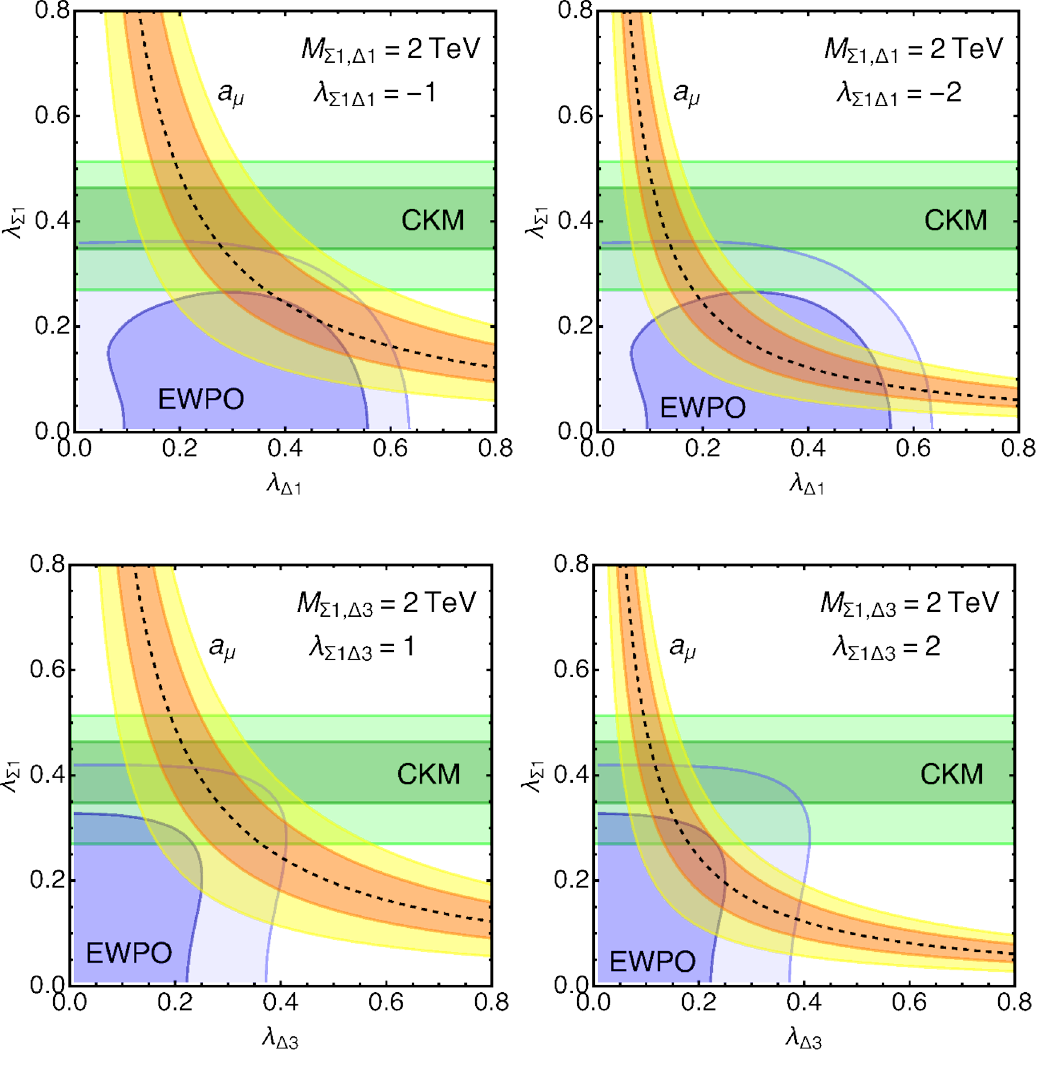
Figure 3. The CKM elements (green), a (cid:22) (orange, yellow), EWPO (blue) and (cid:22) (cid:22)(cid:22) are evaluated as functions of (cid:21) (cid:6) and (cid:21) (cid:1) . The other Yukawa couplings which are not shown explicitly in each 1 1 ; 3 plot are set to be zero. For each observable, the current result is explained at the 1 (cid:27) (2 (cid:27) ) level in the thick (thin) colored region, while the upper limit from the Higgs signal strenght (cid:22) (cid:22)(cid:22) is drawn by the black dashed line, where the left side is allowed at 95% CL by ATLAS. Here, the SFGJ value and the decay rates of K (cid:22) 2 ; (cid:25) (cid:22) 2 are used to obtain the CKM regions.